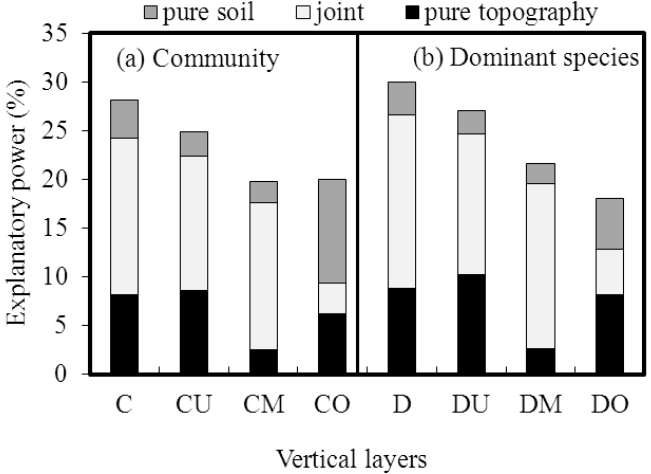
Figure 6. Contribution of soil and topographic factors to variation in species abundance within the subtropical broadleaved forest plot on Dashanchong Forest Farm, China. “Pure soil”, “pure topography”, and “joint” represent the variation explained by pure soil, pure topography, or both topographic and soil variables together, respectively. C, CU, CM, and CO represent the whole stand, understory, midstory, and overstory of the forest, D, DU, DM, and DO represent all stems of dominant species and their corresponding